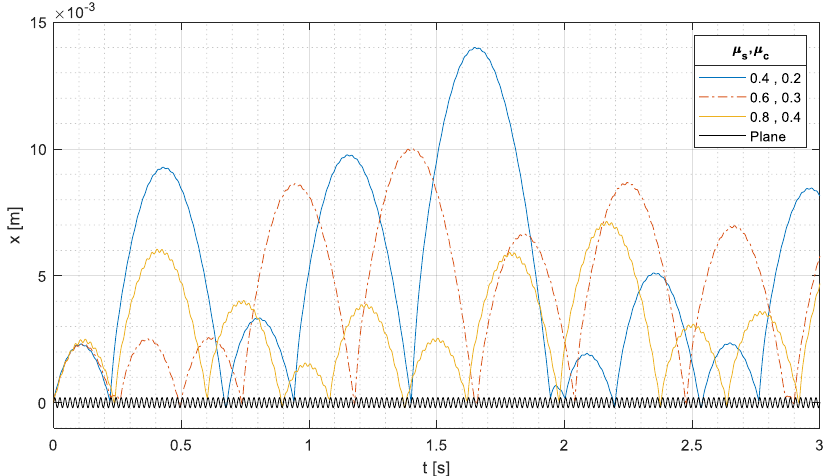
Figure 16. Numerical results, displacement of the cylindrical part along the track, 𝜃 = 3° , 𝜓 = 0 , 𝑓 𝑣 =